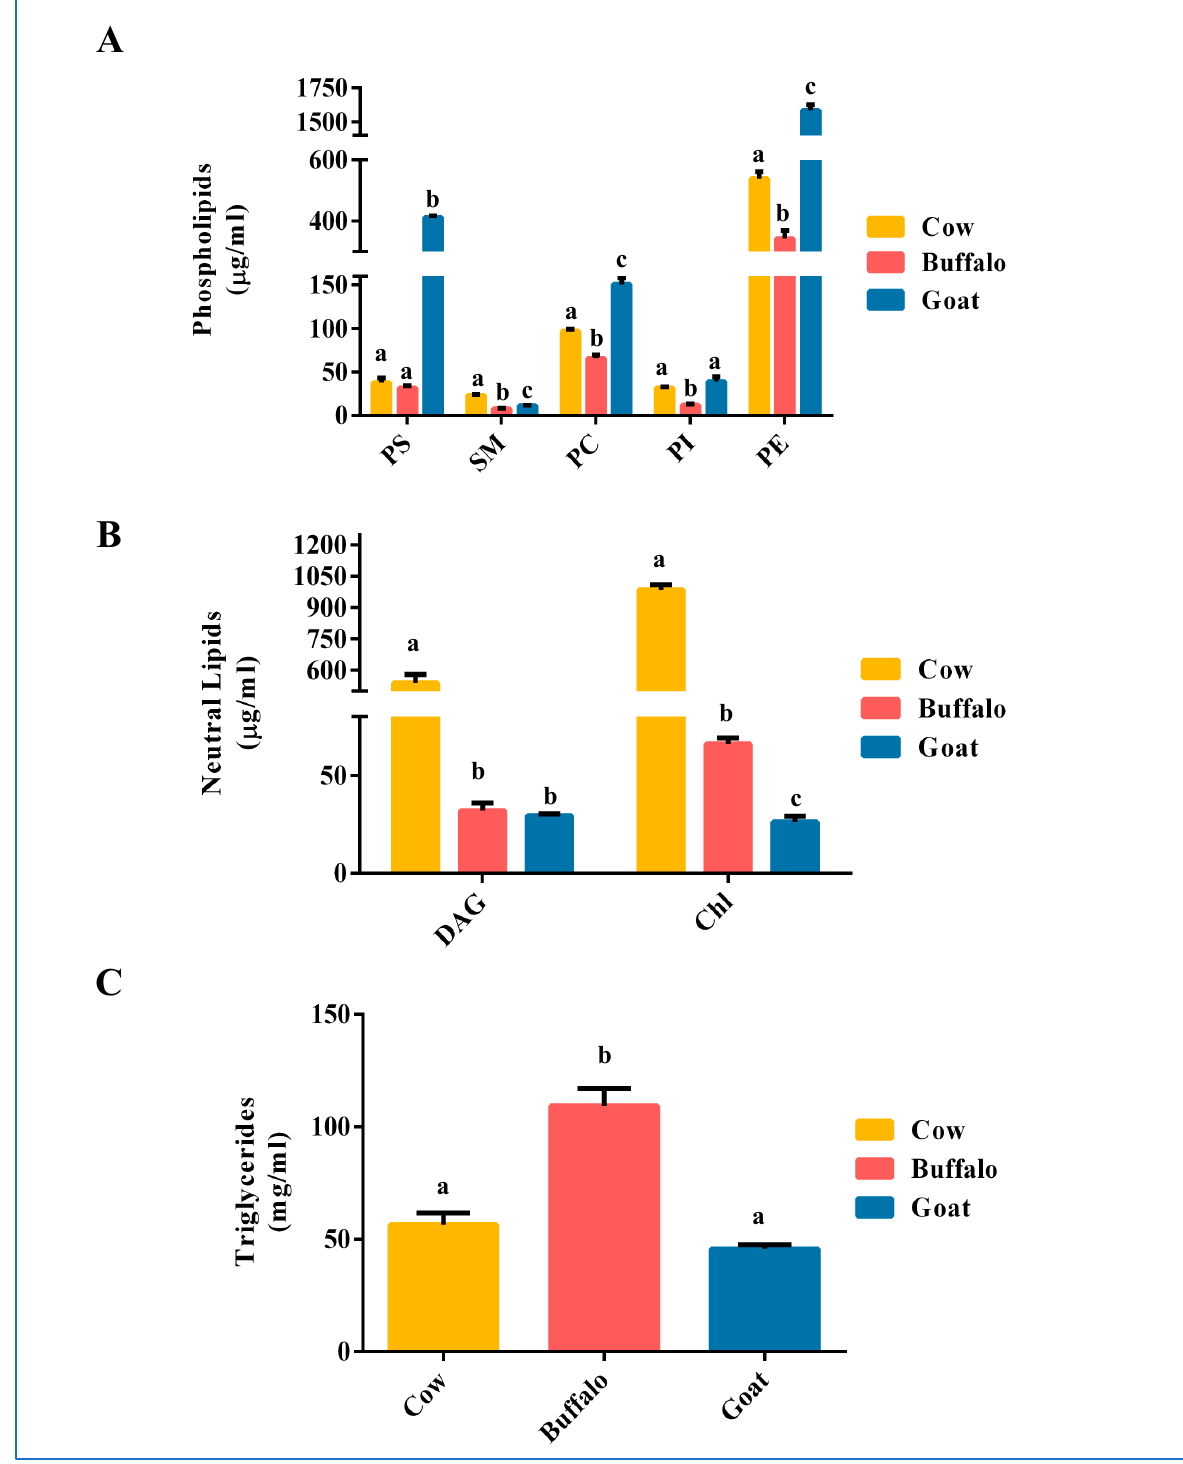
Figure 3. Concentration of lipids present in milk fat globules of cow, goat, and water buffalo; ( A ) Polar lipids, ( B ) Diglycerides and Cholesterol and ( C ) Triglycerides. Data indicate the mean values of lipid concentration ± standard error of the mean (SEM) of biological and technical replicates. Different letters indicate a significant difference ( p ≤ 0.001).